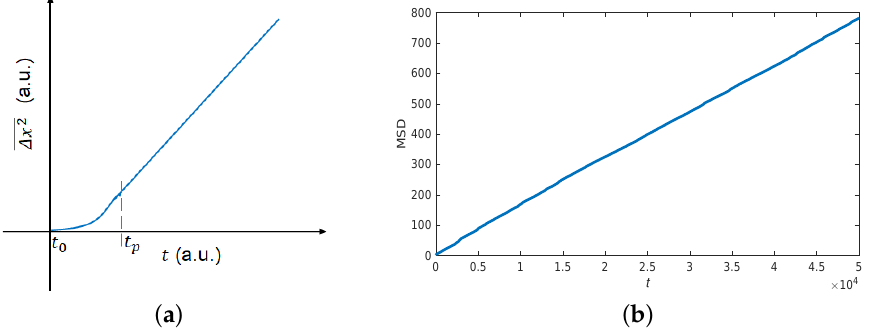
Figure 5. ( a ) Mean Square Displacement (MSD) of a Brownian particle. ( b ) MSD for the time series generated by the electronic